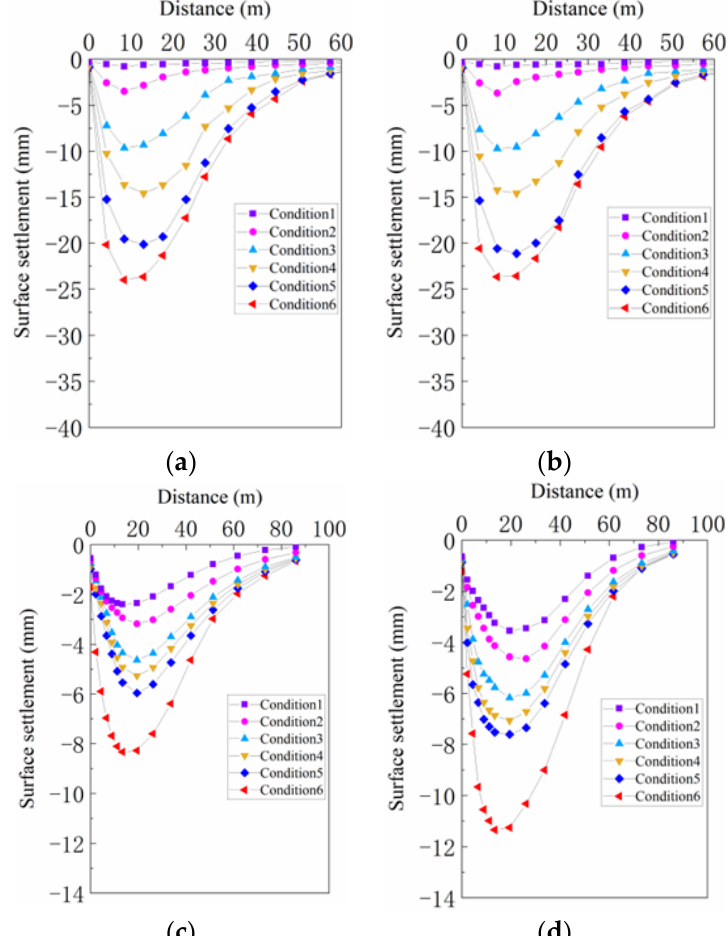
Figure 11. Surface settlement curves at various points under different working conditions. ( a ) Point A1; ( b ) Point B1; ( c ) Point C1; ( d ) Point D1.